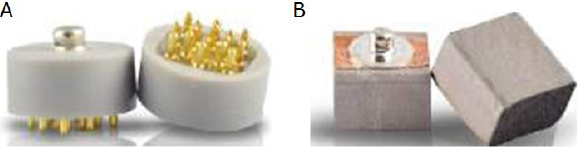
Figure 3. The dry sensors used in the system: ( A ) a spring-loaded sensor and ( B ) a foam sensor applied as the ground and reference electrodes with a clip on each earlobe. The easy-to-handle dry electrodes can be quite helpful in fostering the practical application of EEG in schools while minimizing variances related to measurement errors (e.g., crosstalk between electrodes due to excessive amounts of gel application). Table 2. Specifications of the dry sensors in the wireless EEG acquisition system.